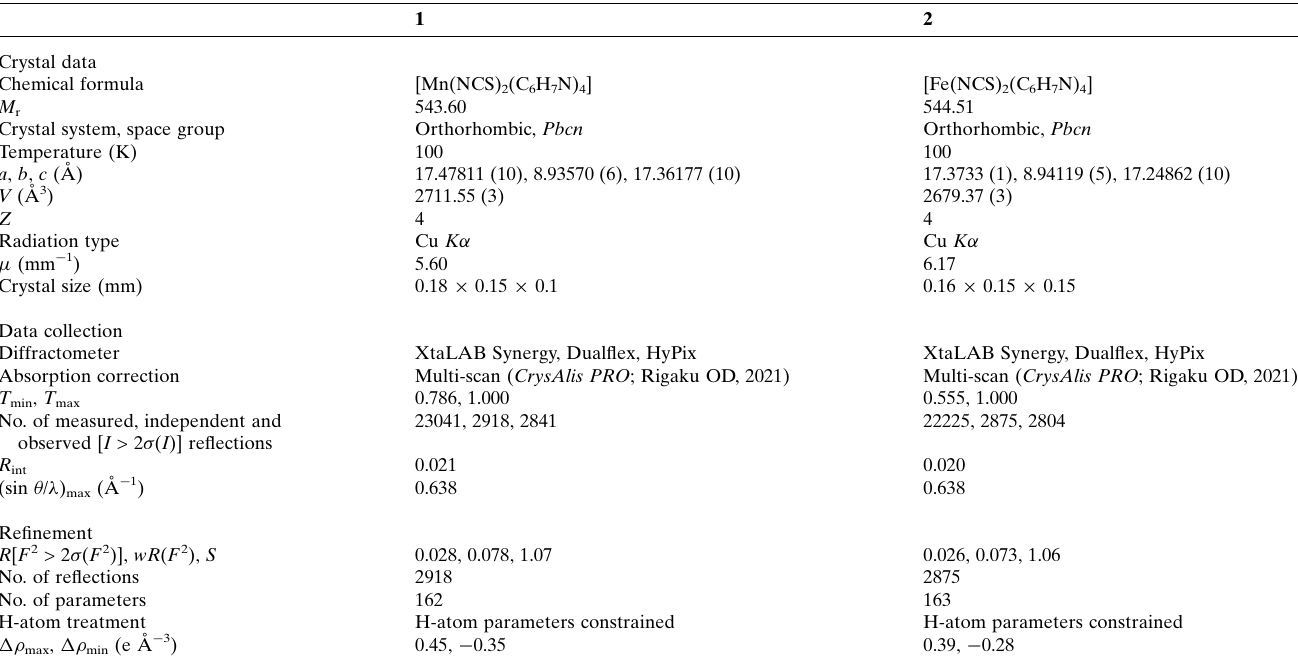
Table 5 Experimental details.